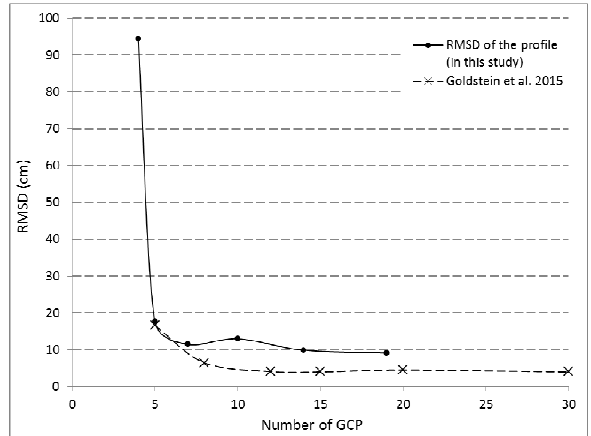
Figure 9. The root mean square discrepancy of the profile is a function of the number of ground control points Another way to measure the vertical accuracy of DSMs is to compare the ellipsoidal heights (GNSS vs DSMs data) from GCPs not used for the georeferencement (Figure 10A). The AAD ranges from 65.12 cm (DSM 1-4) to 1.41 cm (DSM 1-14). With a RMSD respectively ranges from 71.45 cm to 9.85 cm.